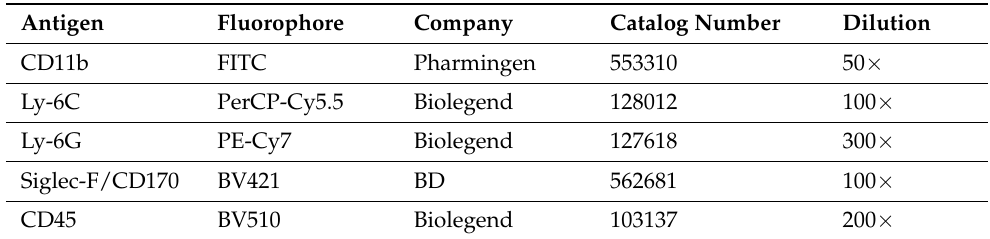
Table 4. Antibodies used to analyze blood and tumor samples of IMR32 tumor-bearing